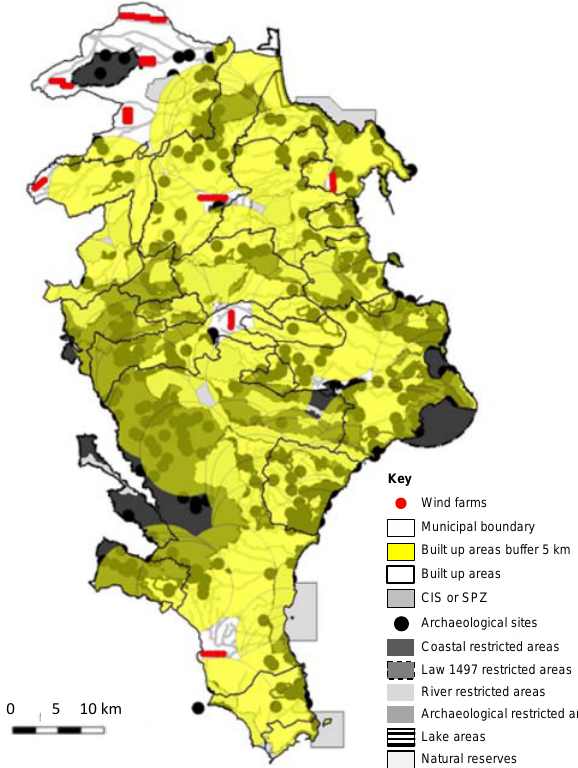
Figure 7. Suitable areas in the Province of Siracusa (our GIS calculations).